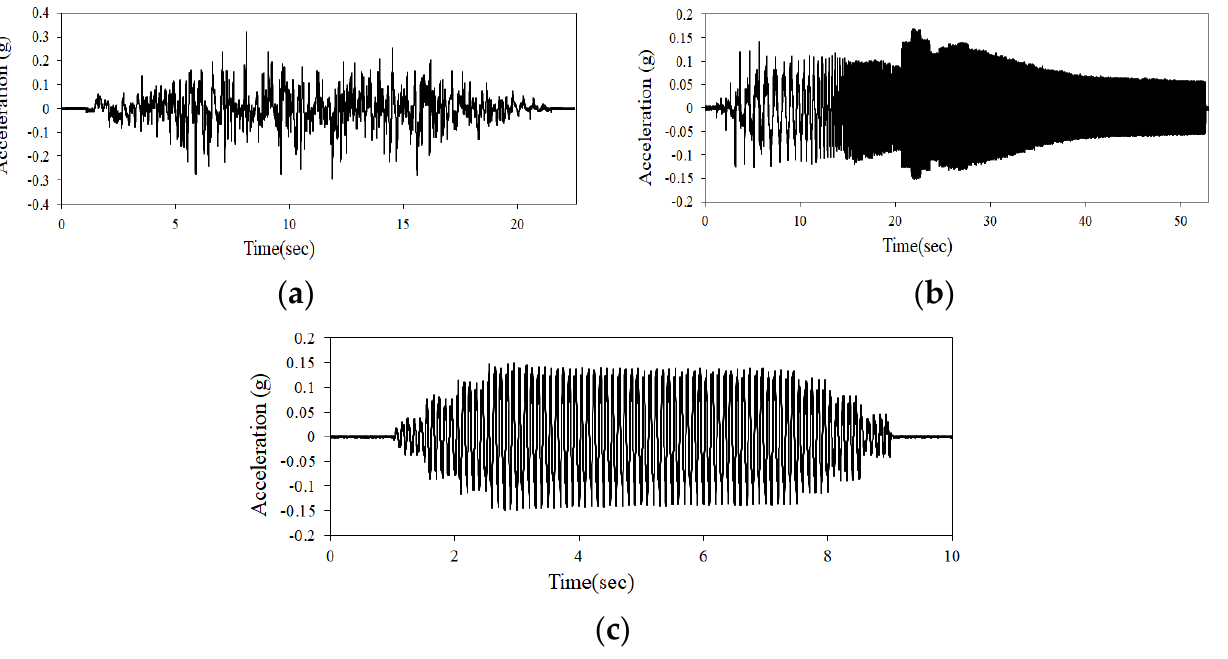
Figure 5. Time-histories of the input ground motions used in this study: ( a ) artificial earthquake wave; ( b ) sine sweep wave; ( c ) sine 10 Hz wave.